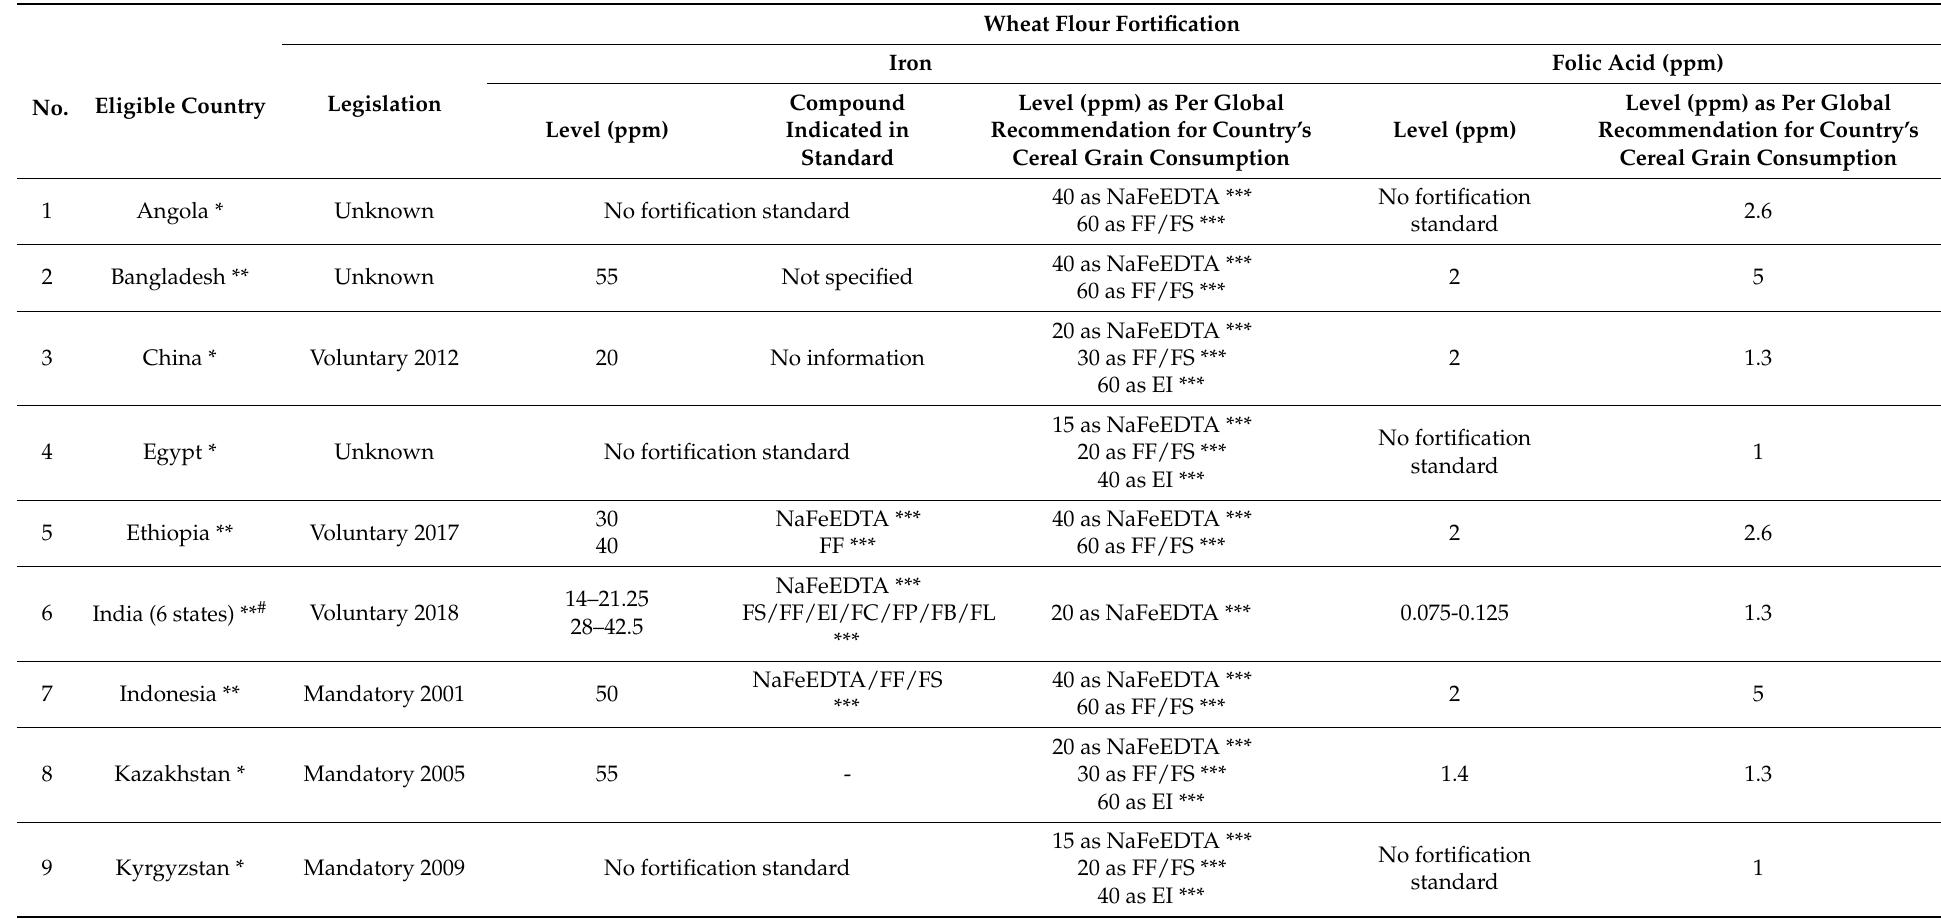
Table 3. Eligible countries that could have a high potential impact through wheat flour fortification: information pertaining to legislative status and inclusion of iron and folic acid in fortification